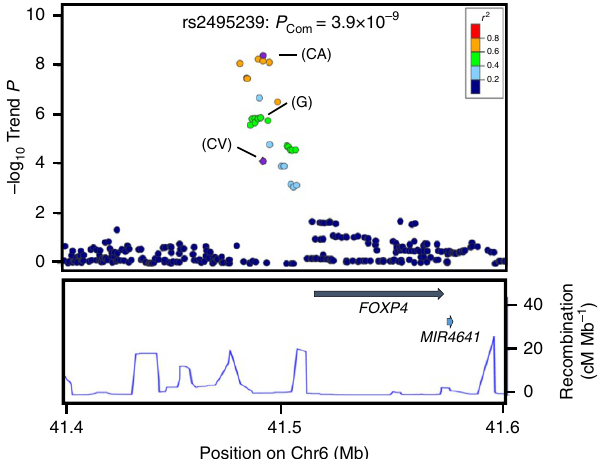
Figure 2 | Regional plot of variations in the FOXP4 region. The marker SNP is shown in purple and the r 2 values for the other SNPs are indicated by different colours. Correlations were estimated using data from the 1000 Genomes Project. Genes within the region of interest are annotated and are indicated by arrows. The blue lines indicate the recombination rates in centimorgans (cM) per megabase (Mb). Circles represent the location and –log 10 ( P Trend values) of each variant. The –log 10 P Trend values of the marker SNPs are shown for the GWAS (G), the combined validation study (CV) and the total combined study